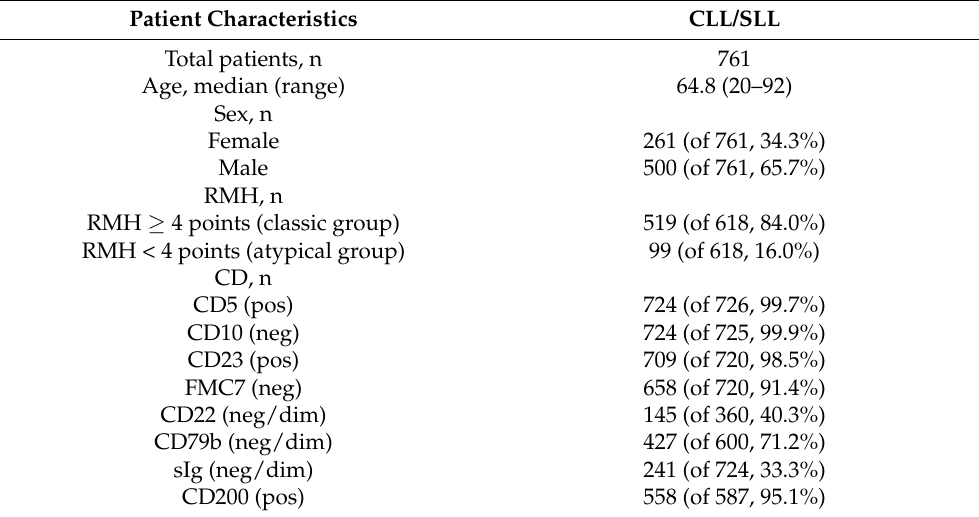
Table 1. Summary of the patients’ general clinical characteristics and